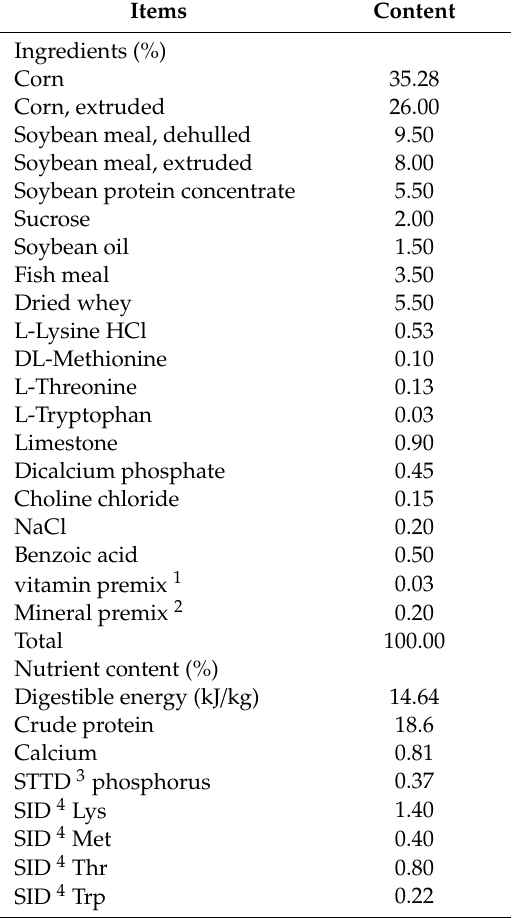
Table 1. Ingredients and nutrient contents of the basal